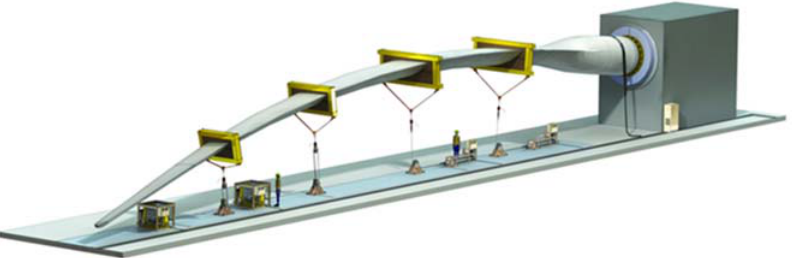
Figure 1. Mode of application of forces to static bending. Reprinted with permission from Ref. [18] Copyright 2022, MTS Wind Turbine Blade Static Test Solutions, Available online: https://www.mts.com/en/applications/energy/wind ‐ turbine ‐ testing (Accessed 6 August 2022).